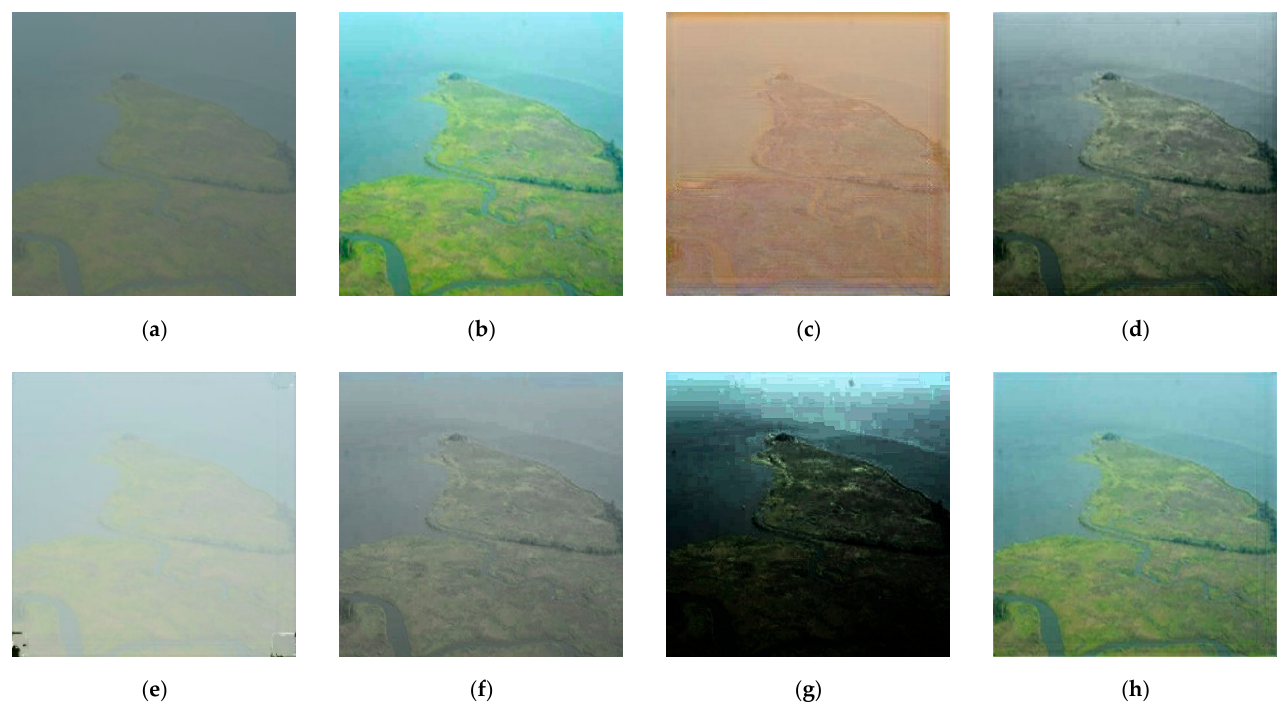
Figure 9. Foggy image #1: ( a ) input, ( b ) target, ( c ) CycleGAN, ( d ) Lum CycleGAN, ( e ) EV GAN, ( f ) HDRCNN, ( g ) ExpandNet, and ( h ) the proposed model.